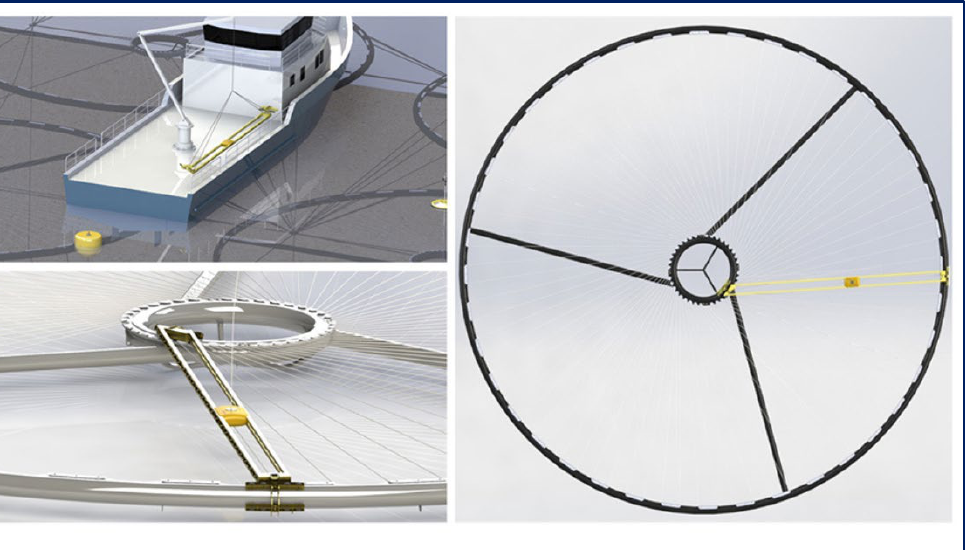
tions/ (accessed on 22 September 2022))